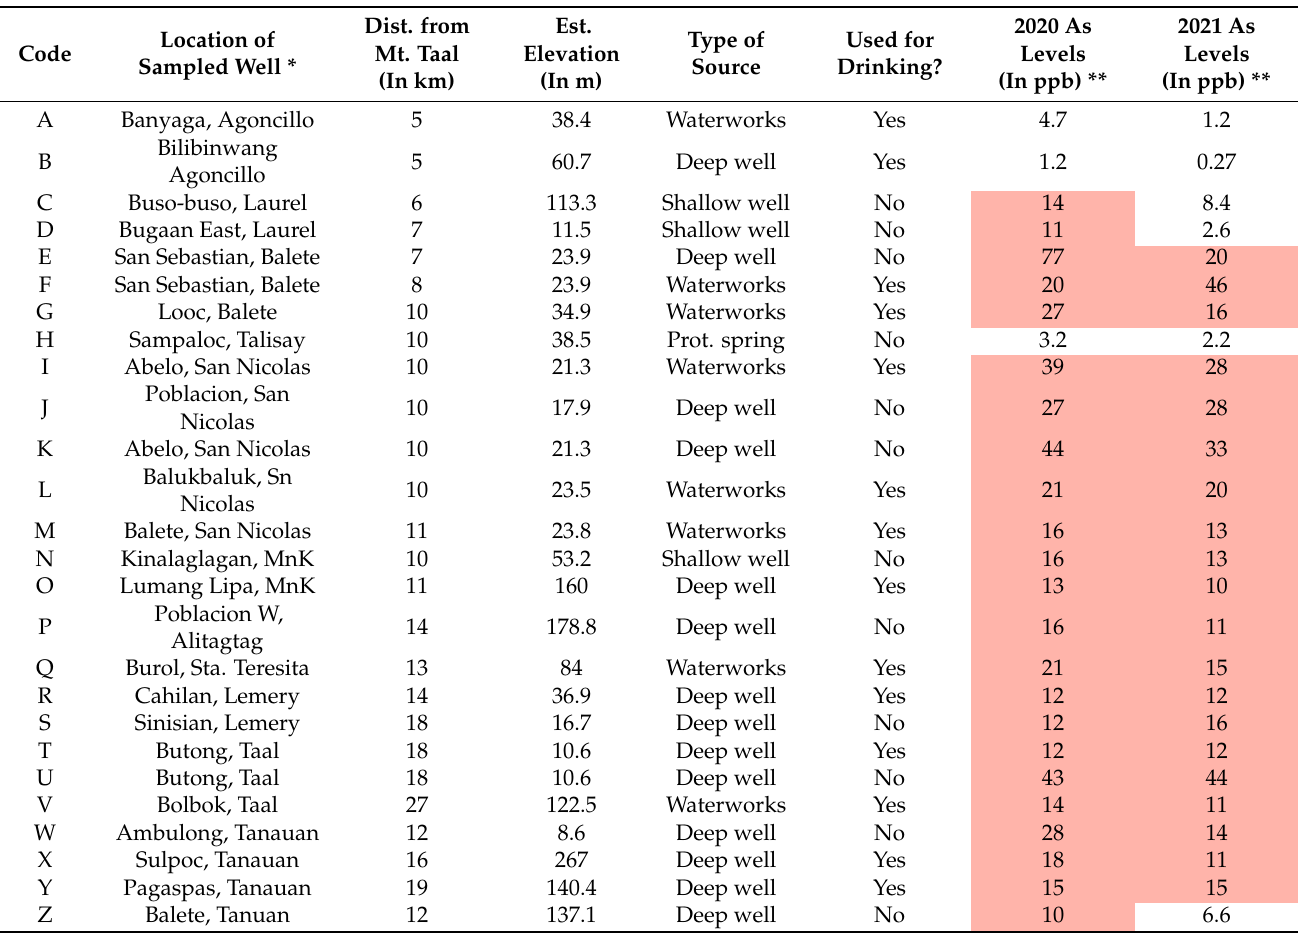
Table 1. Profile and As levels of study wells in selected municipalities surrounding Taal volcano, 2020 vs.